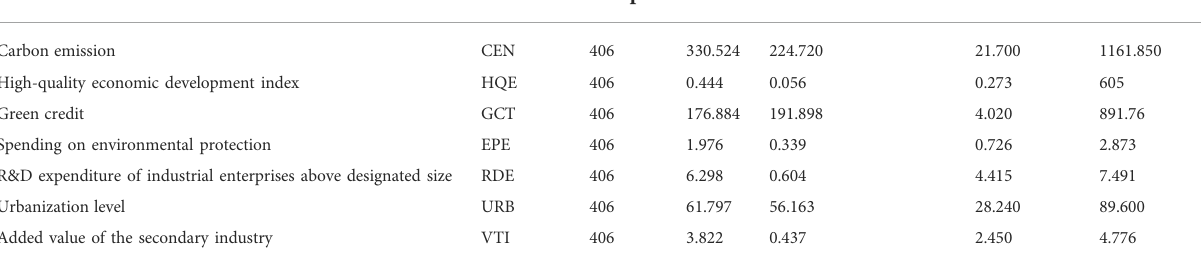
TABLE 3 Descriptive statistics of variables.